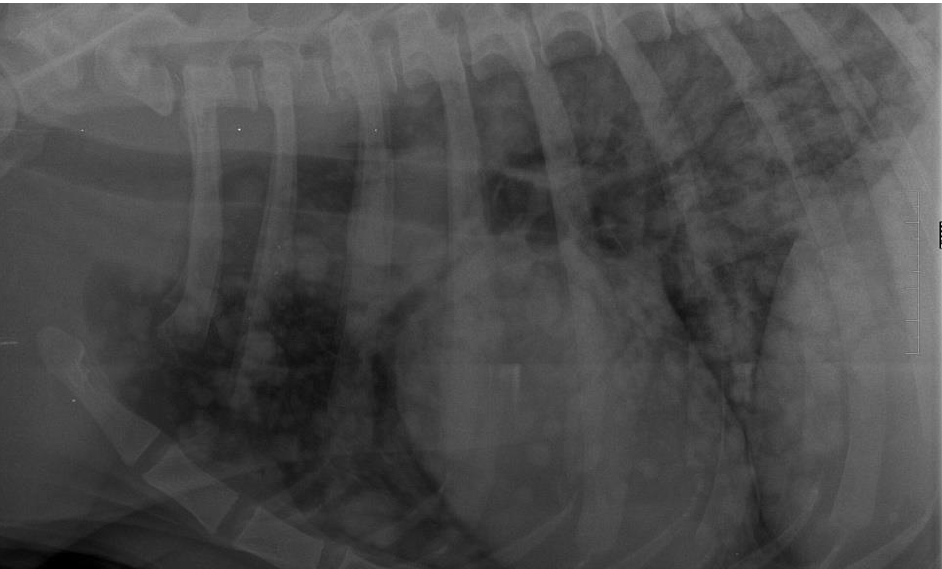
Figure 12. Lateral thoracic radiograph of a dog showing multiple small round shadows scattered in the entire cranial and caudal pulmonary fields. The shadows were diagnosed as a pulmonary metastasis of mammary gland neoplasm in the autopsy and were identified as carcinoma in the histopathological examination.